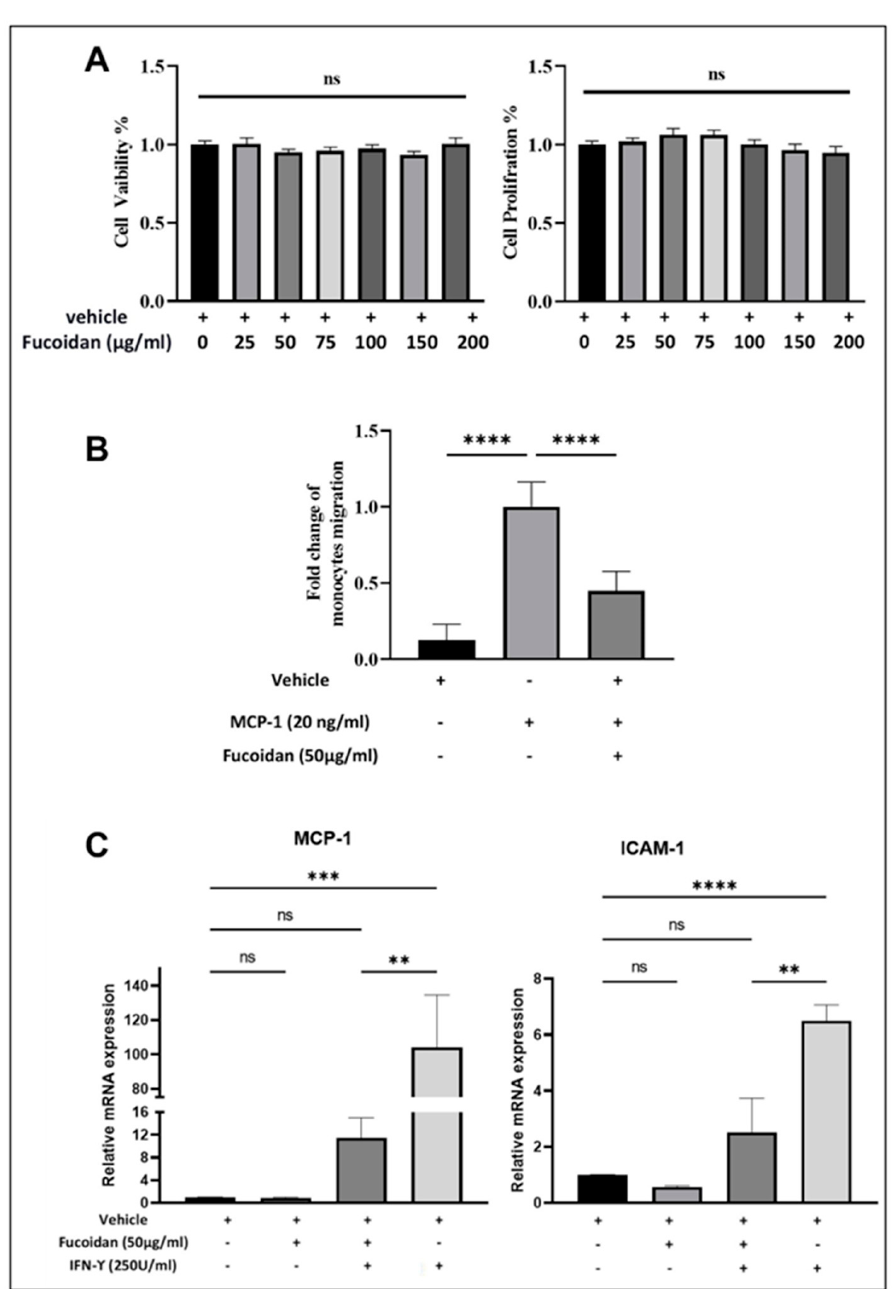
Figure 6. Biological activity of fucoidan on THP-1 cells. ( A ): Percentages of cell viability and proliferation on THP-1 macrophages subjected to various concentrations of fucoidan exposed for 24 h.